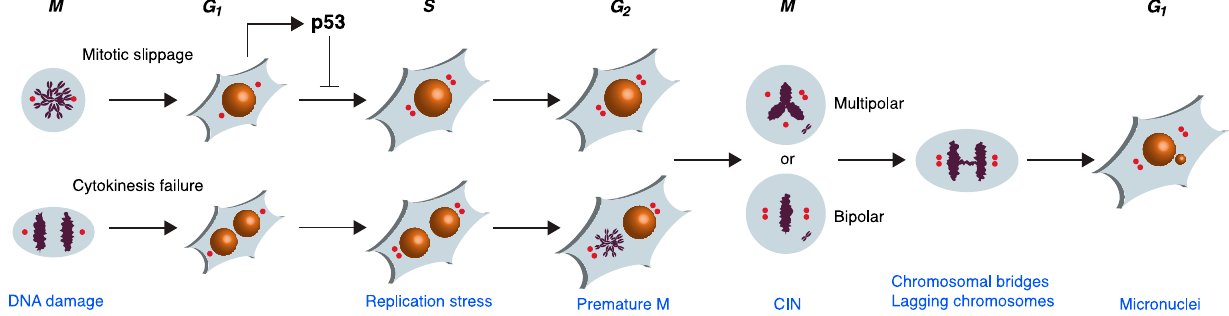
Figure 1. Genome instability following mitotic failure and WGD. Multiple opportunities are present throughout the cell cycle after mitotic failure for triggering genome instability. Cell cycle phases are indicated at the top and the associated genome instability is indicated at the bottom. Cells can exit mitosis without proper division through mitotic slippage or cytokinesis failure. In either case, the tetraploid G 1 cells receive double the number of chromosomes and centrosomes compared to diploid G 1 cells. A p53-dependent G 1 checkpoint is induced due to DNA damage triggered by the abortive mitosis or through extra centrosome-mediated activation of PIDDosome or Hippo pathways. In the absence of the p53-dependent checkpoint, the cells can duplicate the DNA and centrosomes (red dots). Nonetheless, DNA damage is produced during S phase due to replication stress. In tetraploids derived from cytokinesis failure, DNA damage can also be induced in the G 2 nucleus, which is forced into premature mitosis due to exposure to the mitotic environment of the neighboring nucleus within the same cell. Finally, the presence of supernumerary centrosomes can result in multipolar spindles during the following mitosis. Alternatively, pseudobipolar spindles can be formed by the clustering or inactivation (not shown in the Figure) of centrosomes. The high rate of syntelic and merotelic attachments in both multipolar and pseudobipolar mitosis promotes chromatin bridges and lagging chromosomes during anaphase. Chromatin bridges and lagging chromosomes contribute to genome instability by causing CIN and the formation of micronuclei, which act as yet another source of DNA damage and genome instability (other possible outcomes of multipolar and pseudobipolar mitosis are not shown). See text for details.